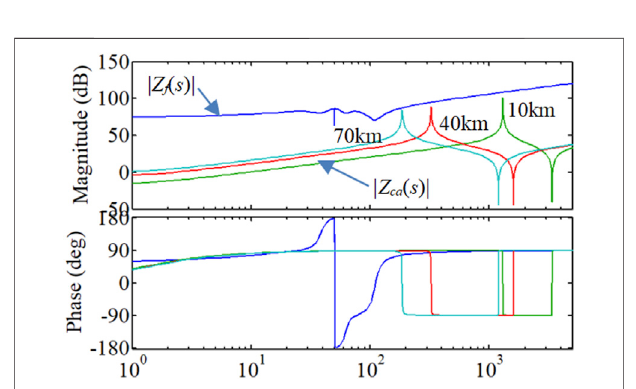
FIGURE8 | Bode diagrams ofZ f (s)and Z ca (s) ofdifferent lengths of220- kV cable for the internal stability analysis. X -axis in Hz. Cable length: 10, 40, 70